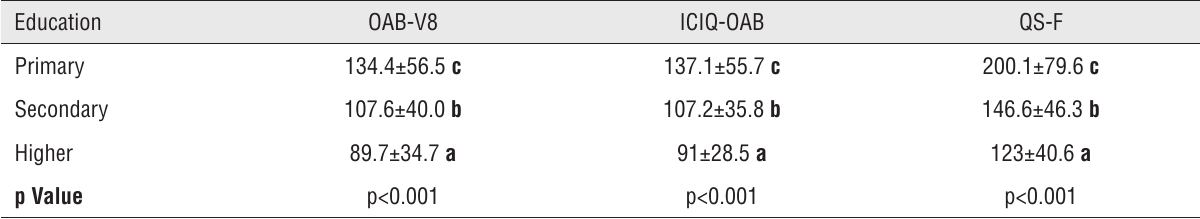
Table 5 - Response time (seconds) for each questionnaire according to education